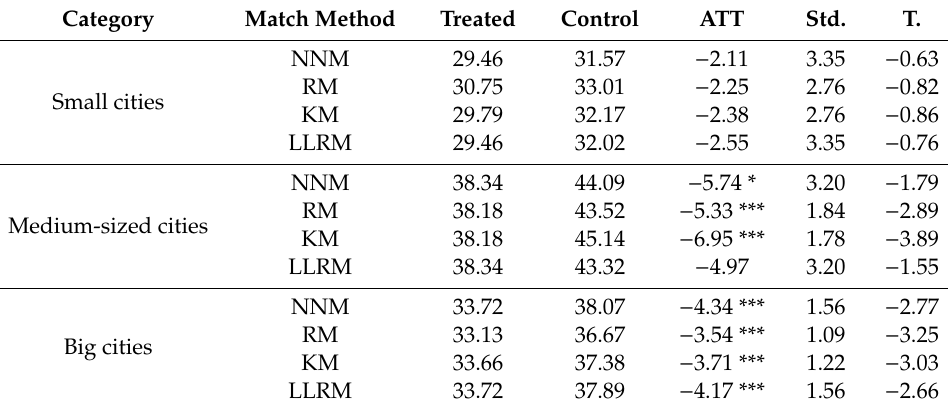
Table 6. ATT estimates in cities of di ff erent